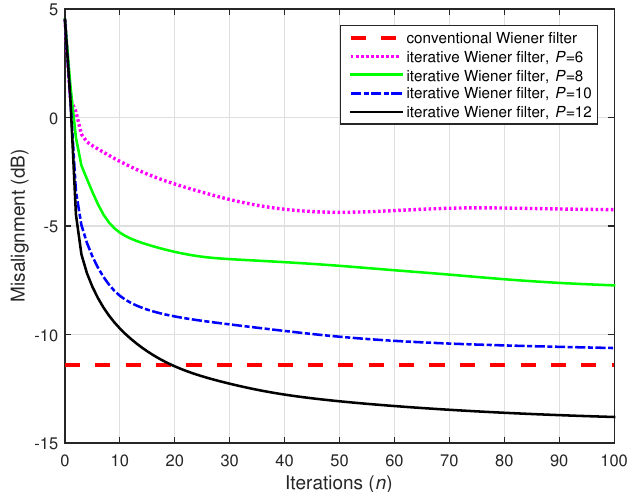
Figure 19. Performances of the conventional and iterative Wiener filters, using N = 10,000. The source signal (white Gaussian noise) was preprocessed with positive and negative half-wave rectifiers, using α = 0.3. The numbers of channels were M = 2 (stereophonic scenario), L = 1024, and SNR = 30 dB.